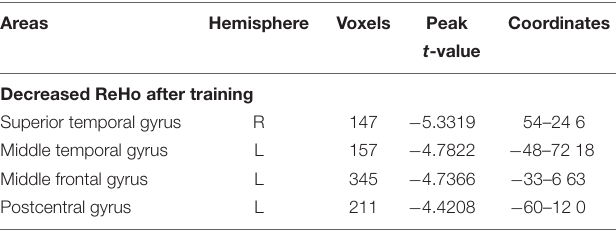
TABLE 1 | Brain areas showing Regional homogeneity (ReHo) difference between post- and pre-training. Areas